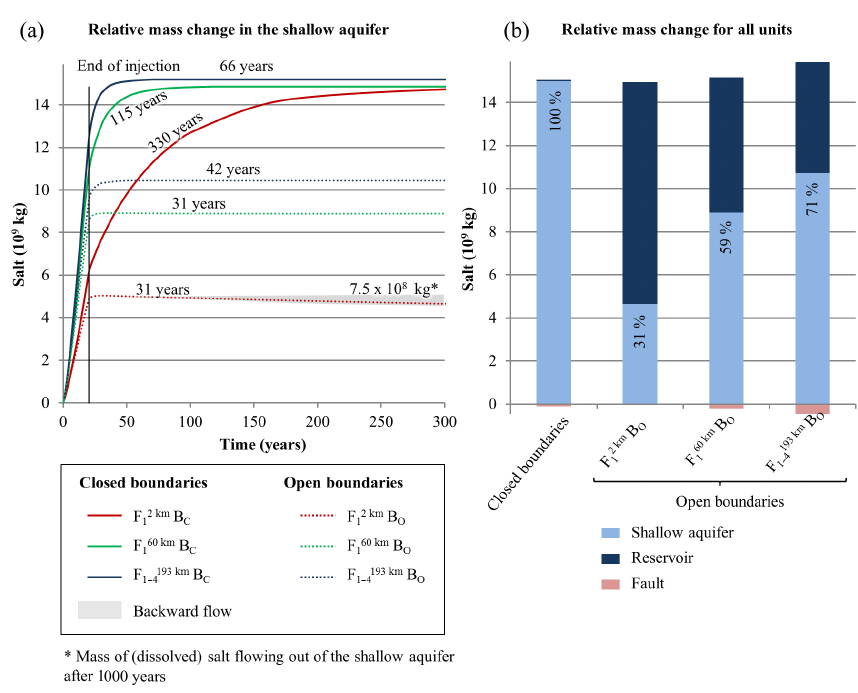
Figure 7. (a) Relative salt mass change in the shallow aquifer shows that the mass of salt displaced into that aquifer corresponds to the total salt mass of injected brine, if reservoir boundaries are closed. As indicated by the duration of mass flow (black numbers), only a temporal effect on fluid migration occurs. (b) Relative mass change for all lithological units after 20 years illustrates a considerably reduced salinisation of the shallow aquifer for open reservoir